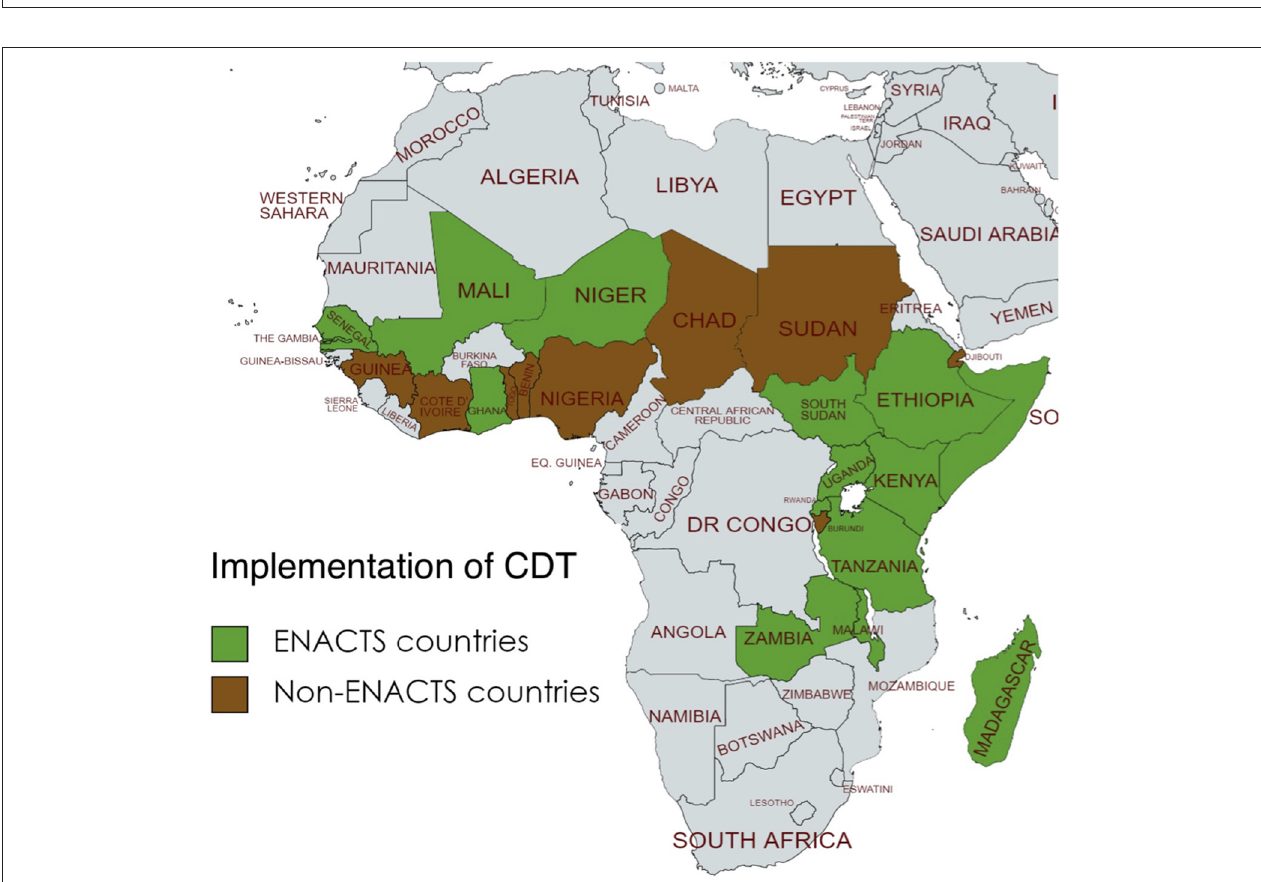
FIGURE 1 | CDT graphical user